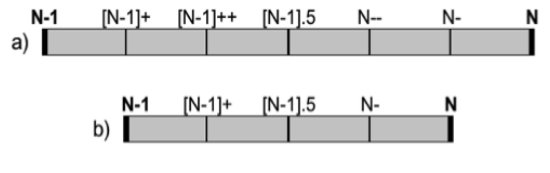
FIGURE 1 | Virtual frets between frets, and their nomen- clature (N is the fret number). a) from the nut to fret VII; b) from fret VII to the last fret.